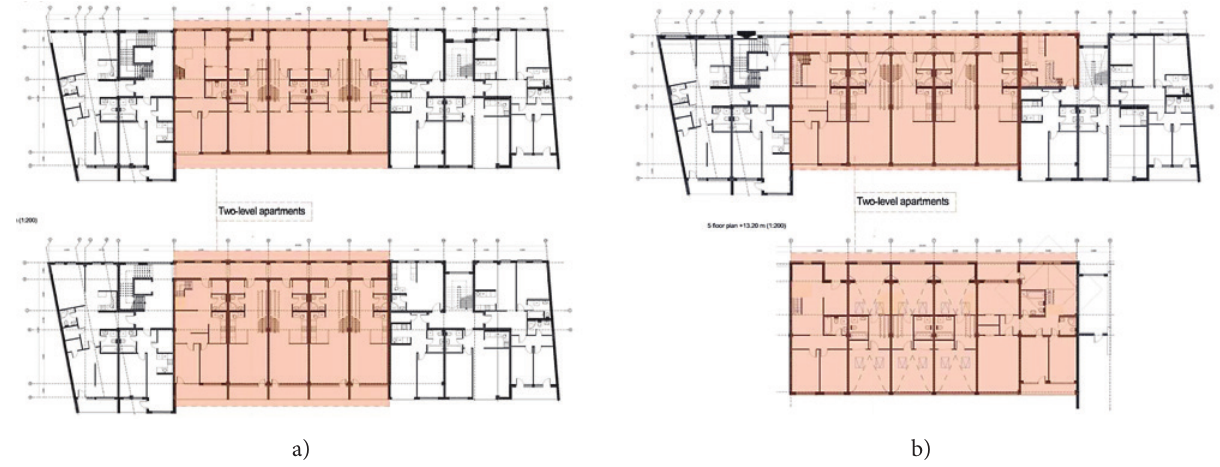
Figure 7. Planning solution of the building (source: Design proposition by author, 2016); a) 2 nd and 3rd floor plans with duplex apartments; b) 4 th and 5 th floor plans with duplex